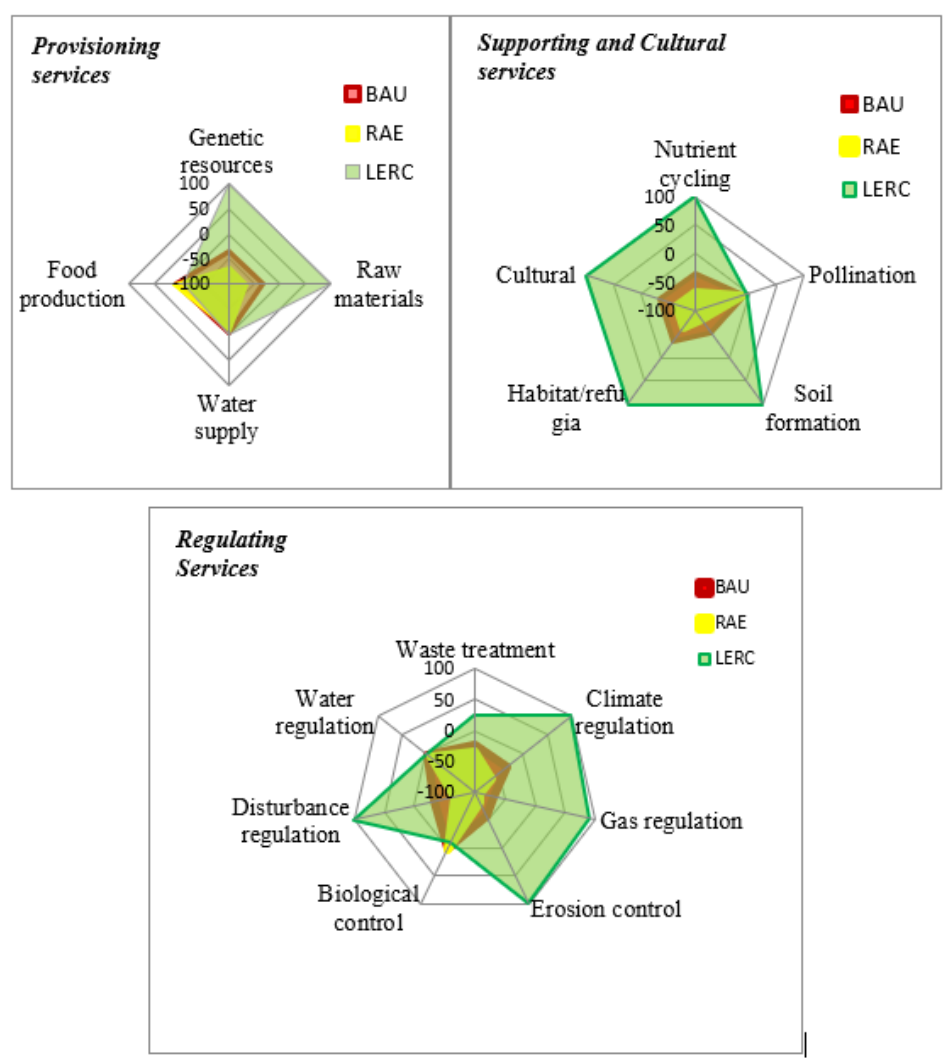
Figure 3. Radar graphs of ES changes in percent compared to the base year 2021 and their associations across four simulated scenarios: Business-as-Usual (BAU), Rapid Agricultural Expansion (RAE) and Landscape Ecosystems Restoration and Conservation